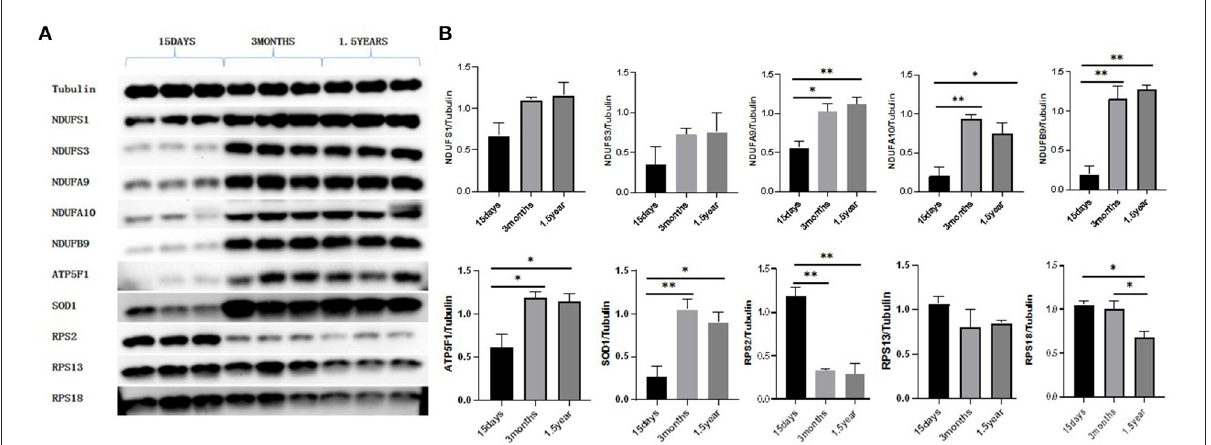
FIGURE9 Western blot results. (A) Protein expression of NDUFS1, NDUFS3, NDUFA9, NDUFA10, NDUFB9, ATP5F1, SOD1, RPS2, RPS13, and RPS18. (B) Gray value analysis results of Western blot. With Tubulin as an internal reference, the expression of proteins related to oxidative phosphorylation pathways, NDUFA9, NDUFA10, NDUFB9, ATP5F1, and SOD1 were significantly lower in the 15-day age group than in the other two age groups. The expression of ribosome-related proteins RPS2 and RPS18 was significantly higher in the 15-day age group than in the other two age groups, which was consistent with the proteomic analysis. * P < 0.05 compared with 15 days group, ** P < 0.01 compared with 15 days